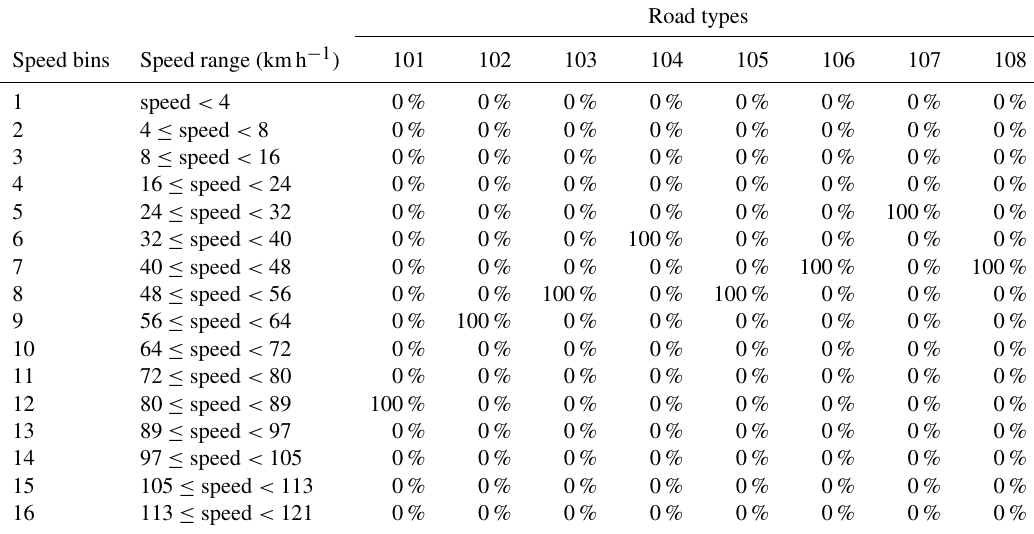
Table F1. Speed range for each road type.